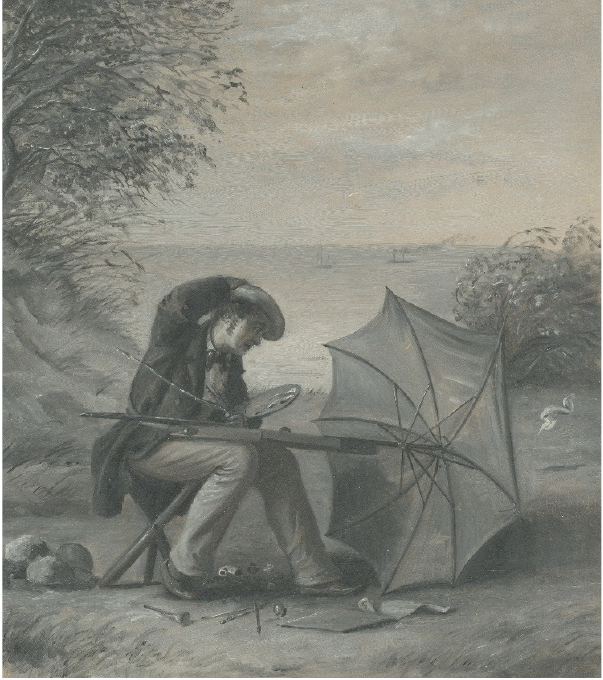
Figure 5. Anonymous French, Accident while Painting in the Open Air, ca. 1820–1830, oil on paper, 31.2 × 27.6 cm. Private collection.